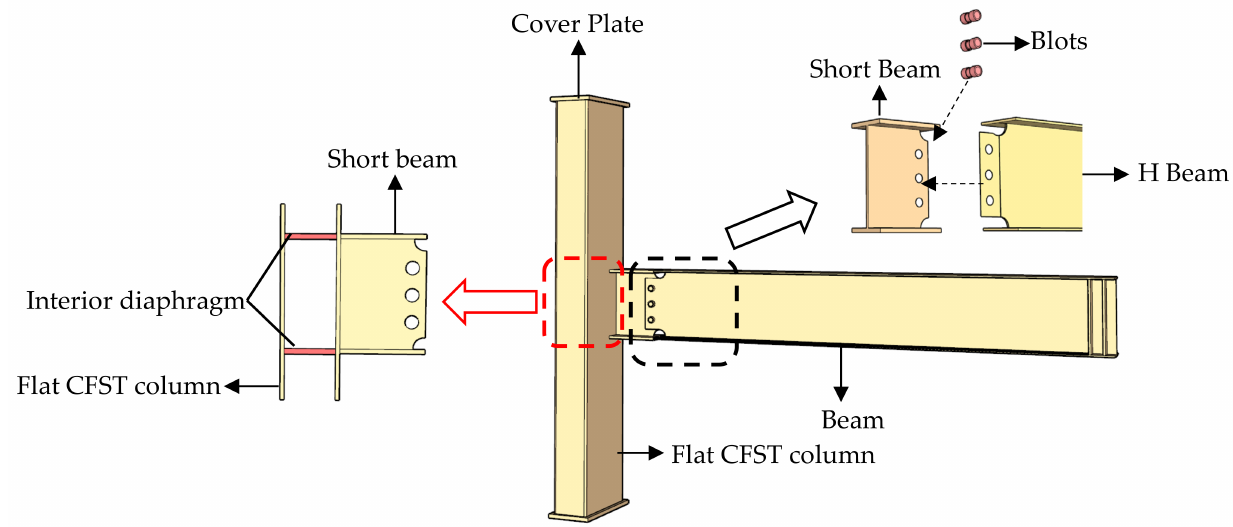
Figure 5. Configuration of the